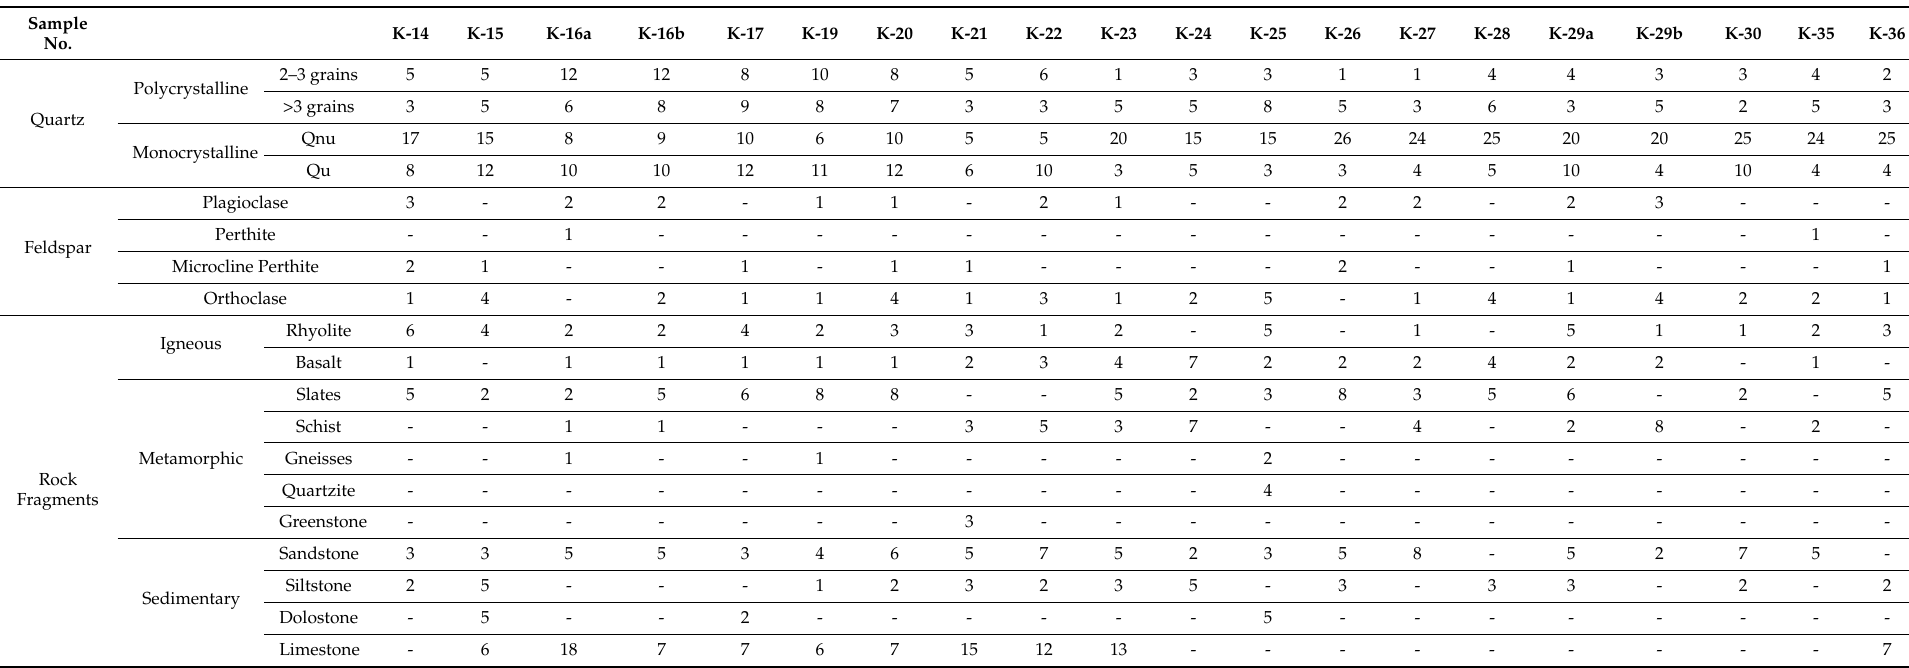
Table 1. Modal mineralogy of feldspathic litharenite and litharenites of Kuldana Formation. Moreover, displaying the end factors of quartzose parts of the sandstone was reevaluated for the diamond diagram of Pettijohn, et al.